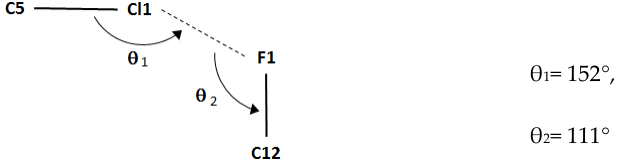
Figure 4. Schematic of short halogen interactions for the title compound.